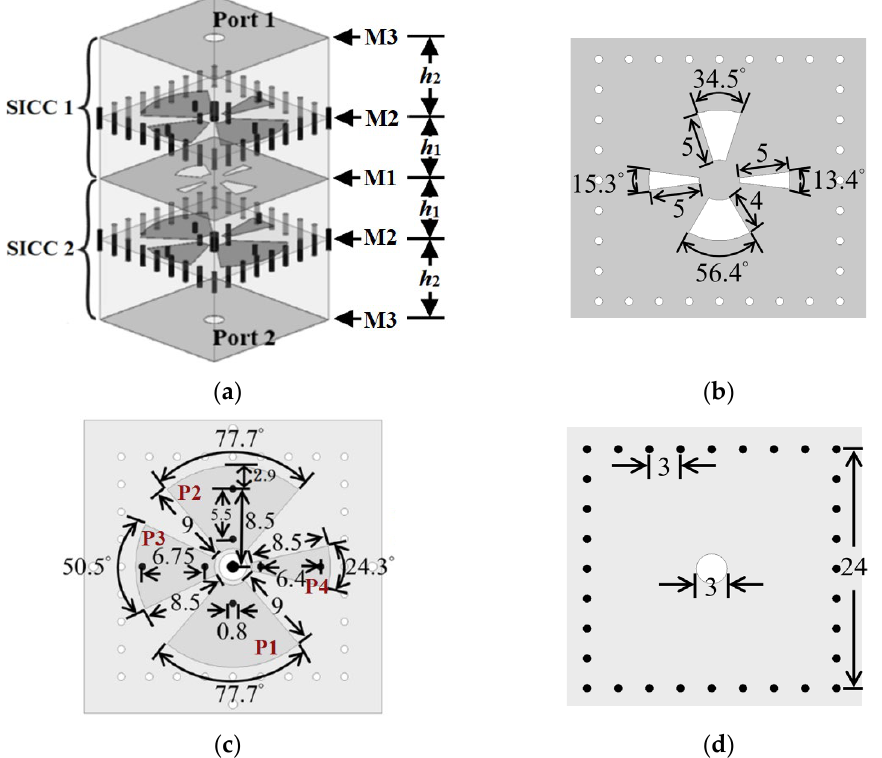
Figure 1. ( a ) The 3D view of the proposed QBF. ( b ) Metal layer M1 (with coupling slots embedded), ( c ) metal layer M2 (consisting of fan-shaped patches), and ( d ) metal layer M3 of each SICC.